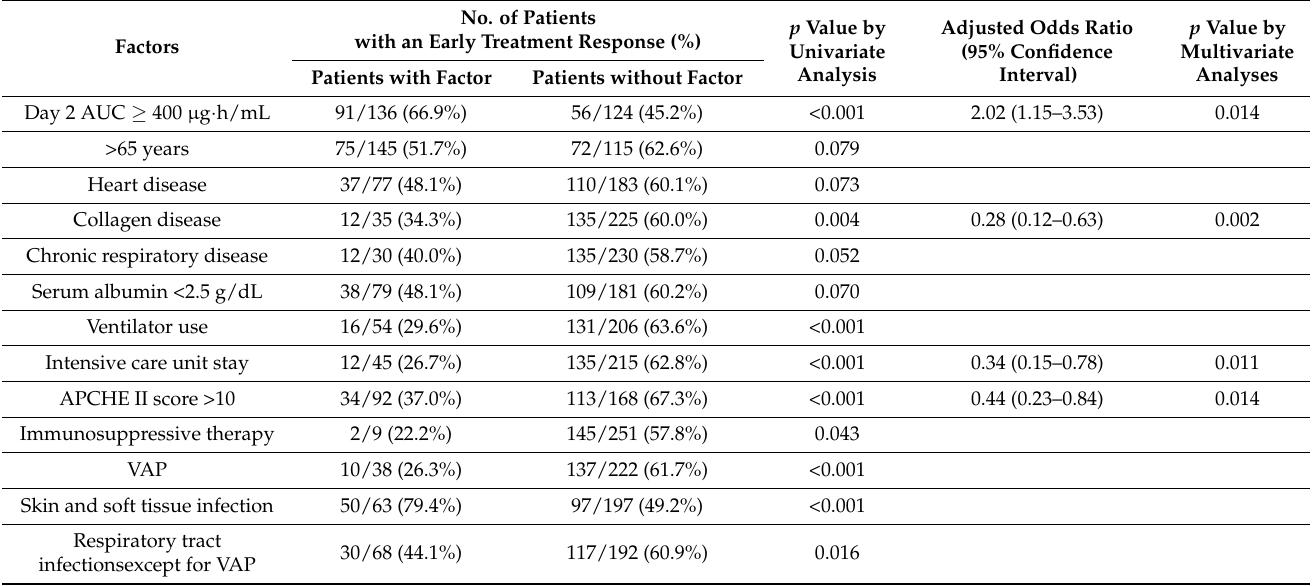
Table 2. Univariate and multivariate analyses of the potential variables affecting an early treat- ment response.